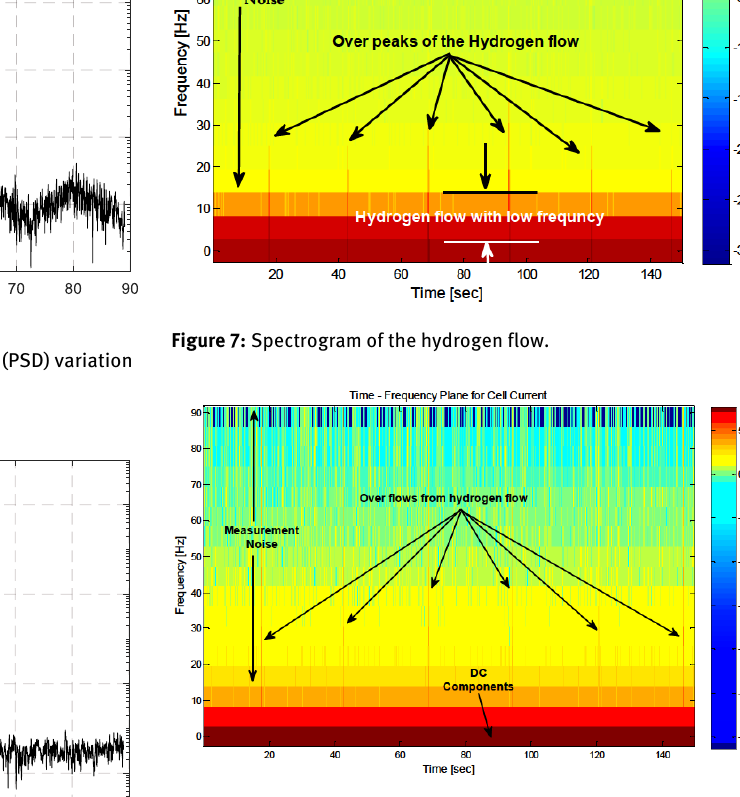
Figure 8: Spectrogram of the cell